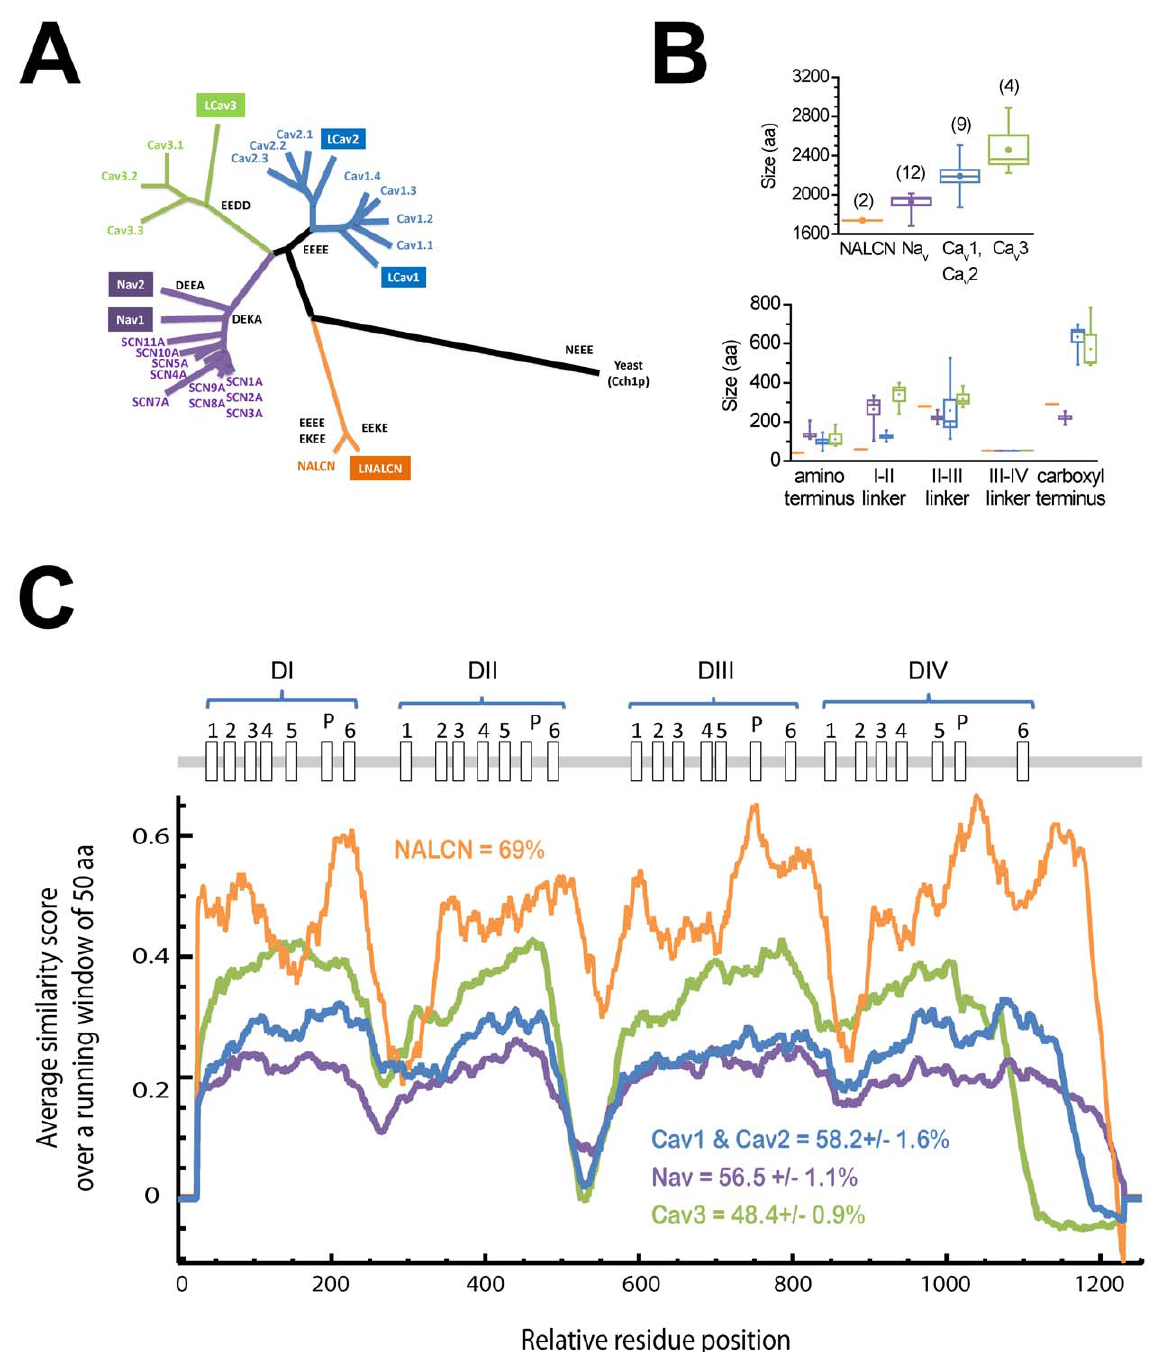
Figure 1. NALCN is unique amongst related 4-domain P-loop voltage-gated cation channels in it being a singleton gene in most reported genomes, and a coding region of small size and high conservation. Comparisons in panels A, B, and C are made between Lymnaea NALCN, LCa v 1, LCa v 2, LCa v 3, Na v 1, Na v 2 and the 21 human homologs. (A) Gene tree of aligned sequences suggest a distant relationship to voltage-gated Ca v and Na v channels, and closer to the singleton yeast calcium channel. Grey letters indicate selectivity filter residues. (B) NALCN is a shorter than other cation channels in total size (top panel) largely because of its short amino terminus and I–II linker (bottom panel). Snail and human NALCN are within + / 2 3 aa of each other in sizes of individual domains and cytoplasmic linkers. (C) Running averages of similarity indicate that snail and human NALCN are much more conserved than other cation channels, with a high level of conservation even in the generally hypervariable cytoplasmic linkers and amino-termini.